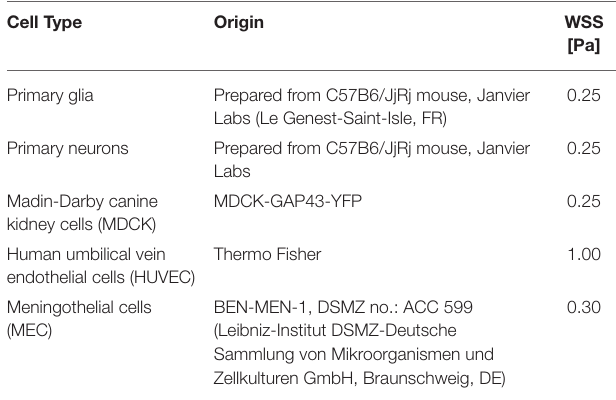
TABLE 1 | Overview of cell types and shear stress levels used in the validation